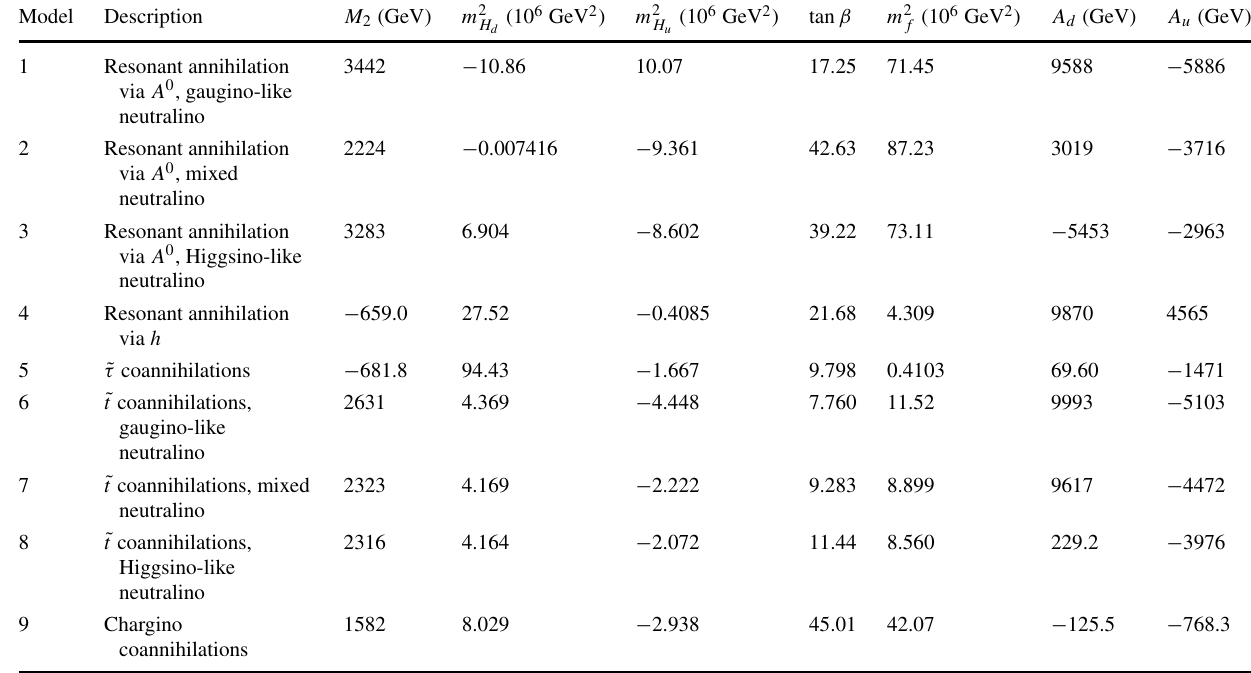
definedatanenergyscaleof1TeV.Asshowninthedescriptioncolumn, the points were chosen to have different types of processes contribute to the relic density calculation